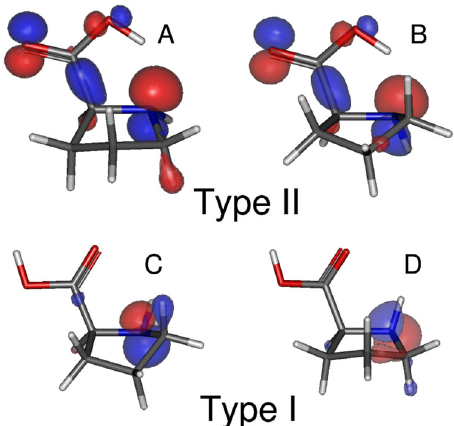
Fig. 3 Hartree-Fock orbital density of the outermost (HOMO) orbital of the four proline conformers labelled A, B, C and D. Type I conformer orbitals appear very localized at the N atom site (colored blue) but this is much less the case of conformer Type II orbitals showing more delocalization with some density also at the O atom sites (red) and, notably, around the C – C α bond. These differences may partially account for the different fragmentation behavior between the two types of